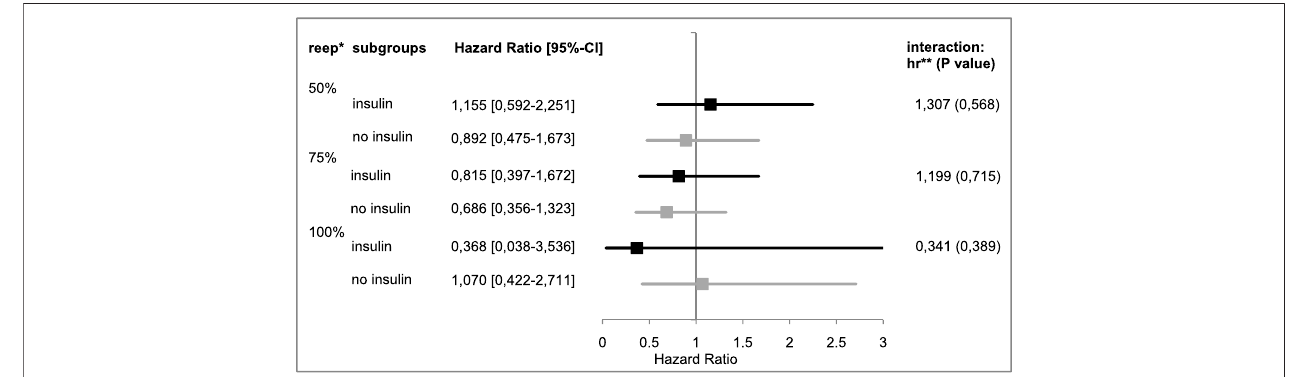
FIGURE4| Hazard ratios of “ insulin ” vs. “ noinsulin ” subgroups.*re-ep,re-epithelializationlevel;**hr,hazard ratio;representsthetherapeuticeffect ofEPOwithits 95% ¬ con fi denceintervalinthesubgroup;andhr < 1representsanegativetherapeuticeffectinthepatientsreceivingEPO;therespectiveinteractioneffectsarelistedon the right.